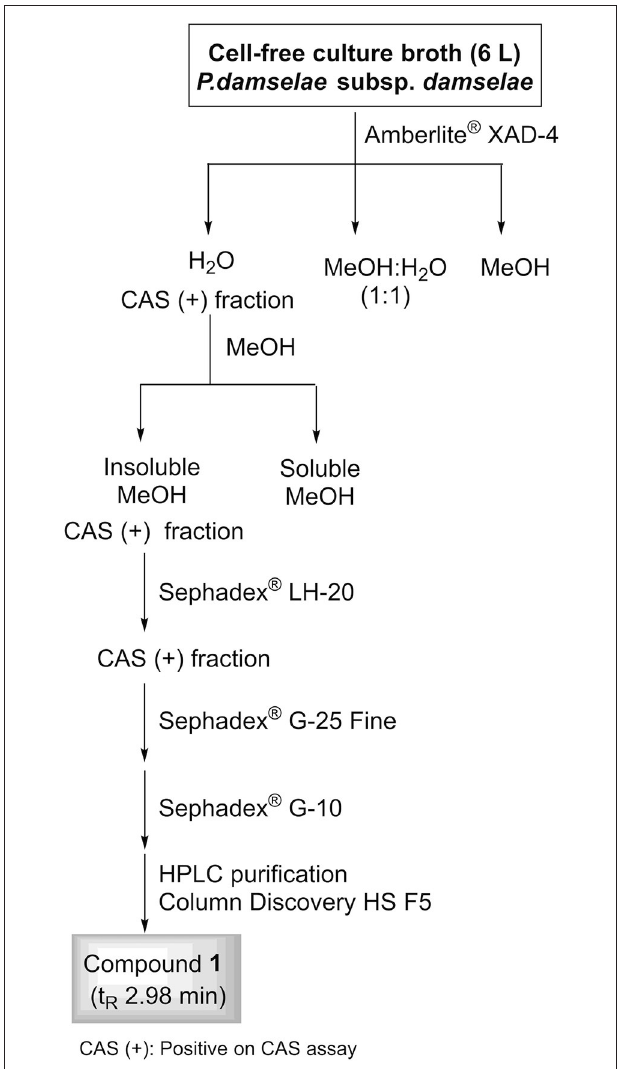
FIGURE 6 | Fractionation flowchart and isolation of citrate (compound 1 ) from the iron-restricted culture supernatants of Pdd strain